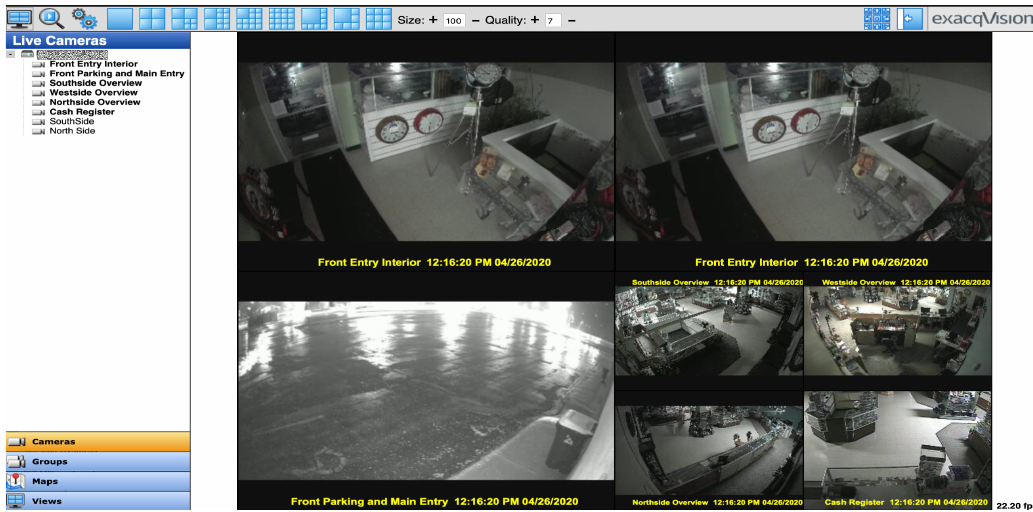
Figure A1. Example of a weakly protected Exacqvision configuration video-surveillance system.